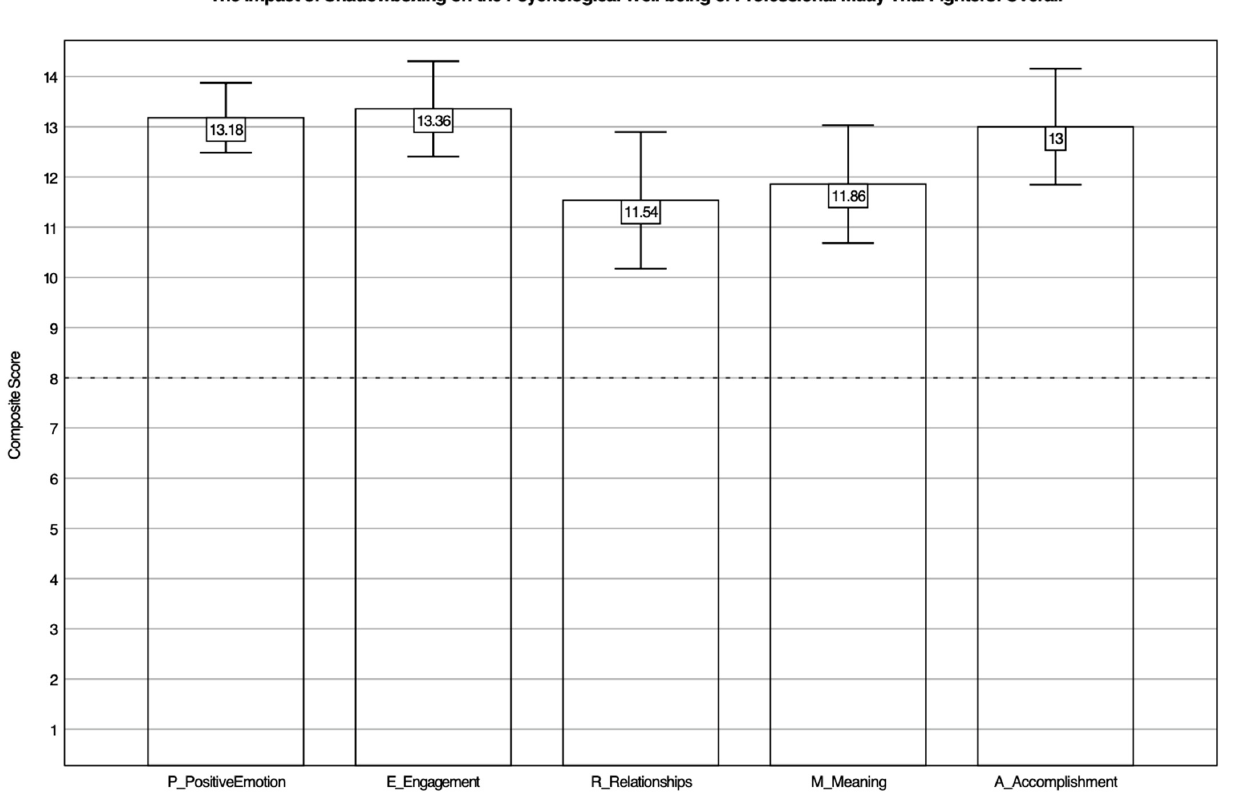
Figure 1. This figure provides a bar plot with 95% confidence intervals (CIs) for overall PERMA scores for professional Muay Thai fighters (n = 14). For each element of psychological well-being, the lowest possible composite score is 2 representing that professional Muay Thai fighters strongly agree that shadowboxing negatively impacts that element of psychological well-being, whereas the highest possible composite score is 14 representing that professional Muay Thai fighters strongly agree that shadowboxing positively impacts that element of psychological well-being. A composite score of 8 (dotted line) reflects a neutral position on whether shadowboxing contributes positively or negatively to that element. Results of this study by Croom [77] show that professional Muay Thai fighters strongly agree that shadowboxing positively contributes to all five component elements of psychological well-being. Statistics were calculated using IBM SPSS Statistics software.